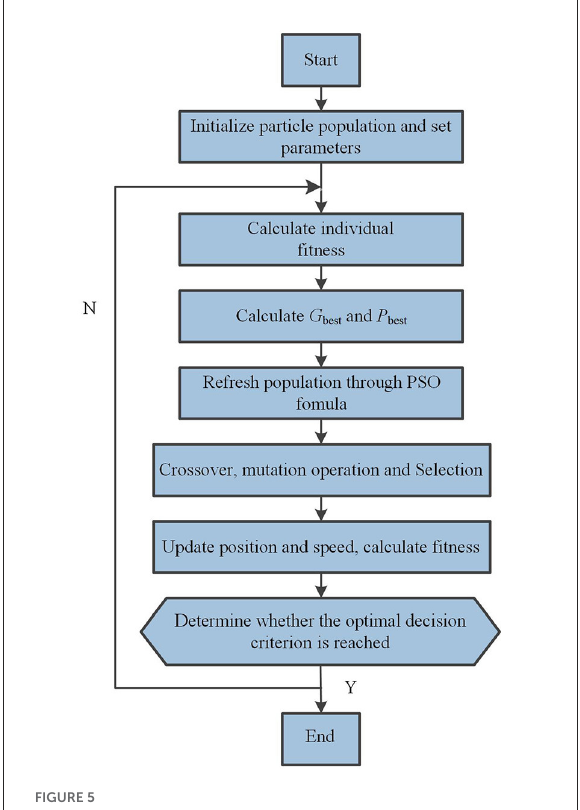
FIGURE5 The optimization process of